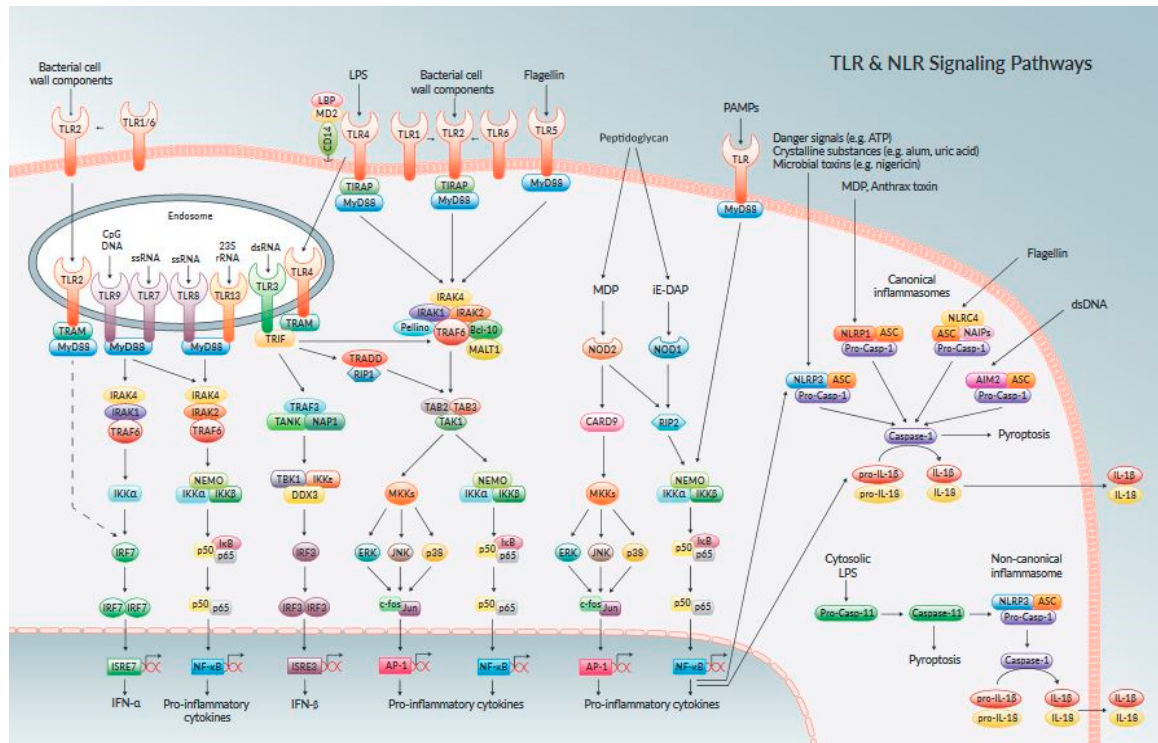
Figure 1. The mechanism of pathogen molecular recognition by Toll-like receptors triggering cellular signaling pathways activation (26,48). The mechanism of PAMP stimulating the cell receptor with their major transduction by biomolecules, which induced various isoforms of the signaling pathway and led to upregulation of pro-inflammatory cytokines and chemokines. The delivery of nanodrugs in suppressing inflammatory response in any part of the signaling pathways is essential in nanotherapeutic development against endometritis.